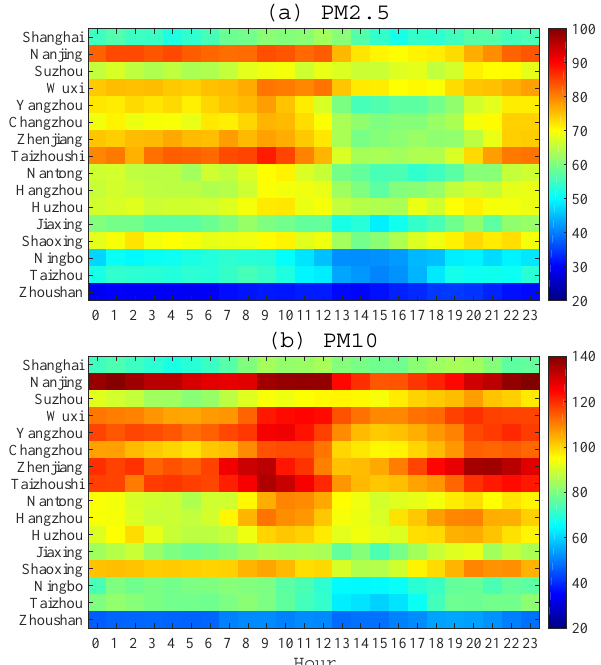
Figure 4. Diurnal variations in PM 2 . 5 (a) and PM 10 (b) concentra- tions in 16 cities of the YRD (unit: µgm − 3